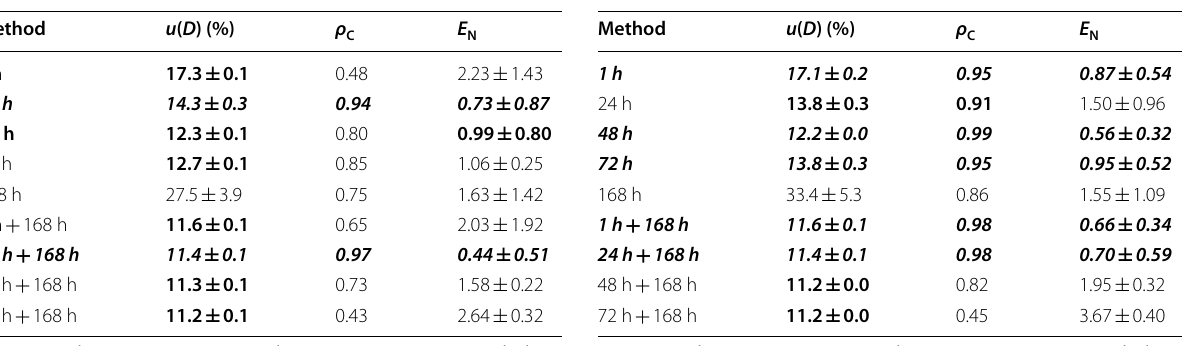
for the simplified N